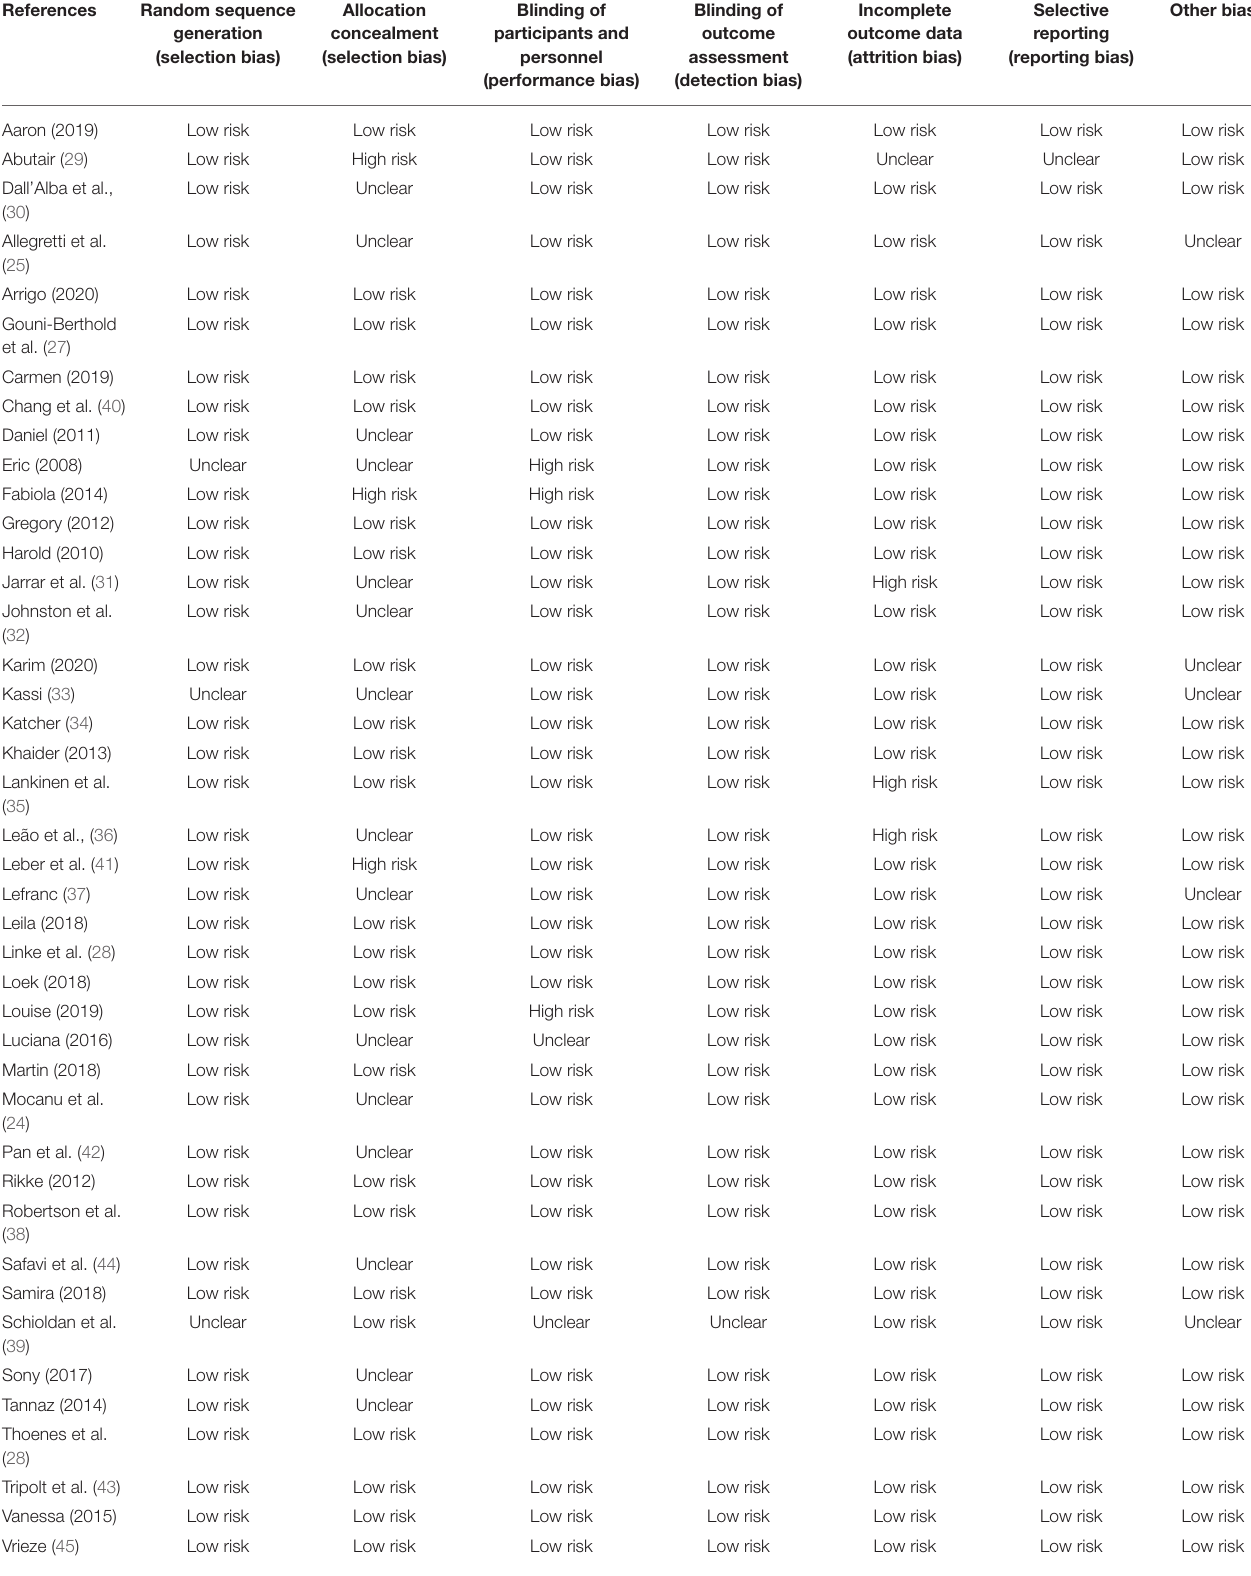
TABLE 2 | Risk of bias summary Judgements about each risk of bias item for each included